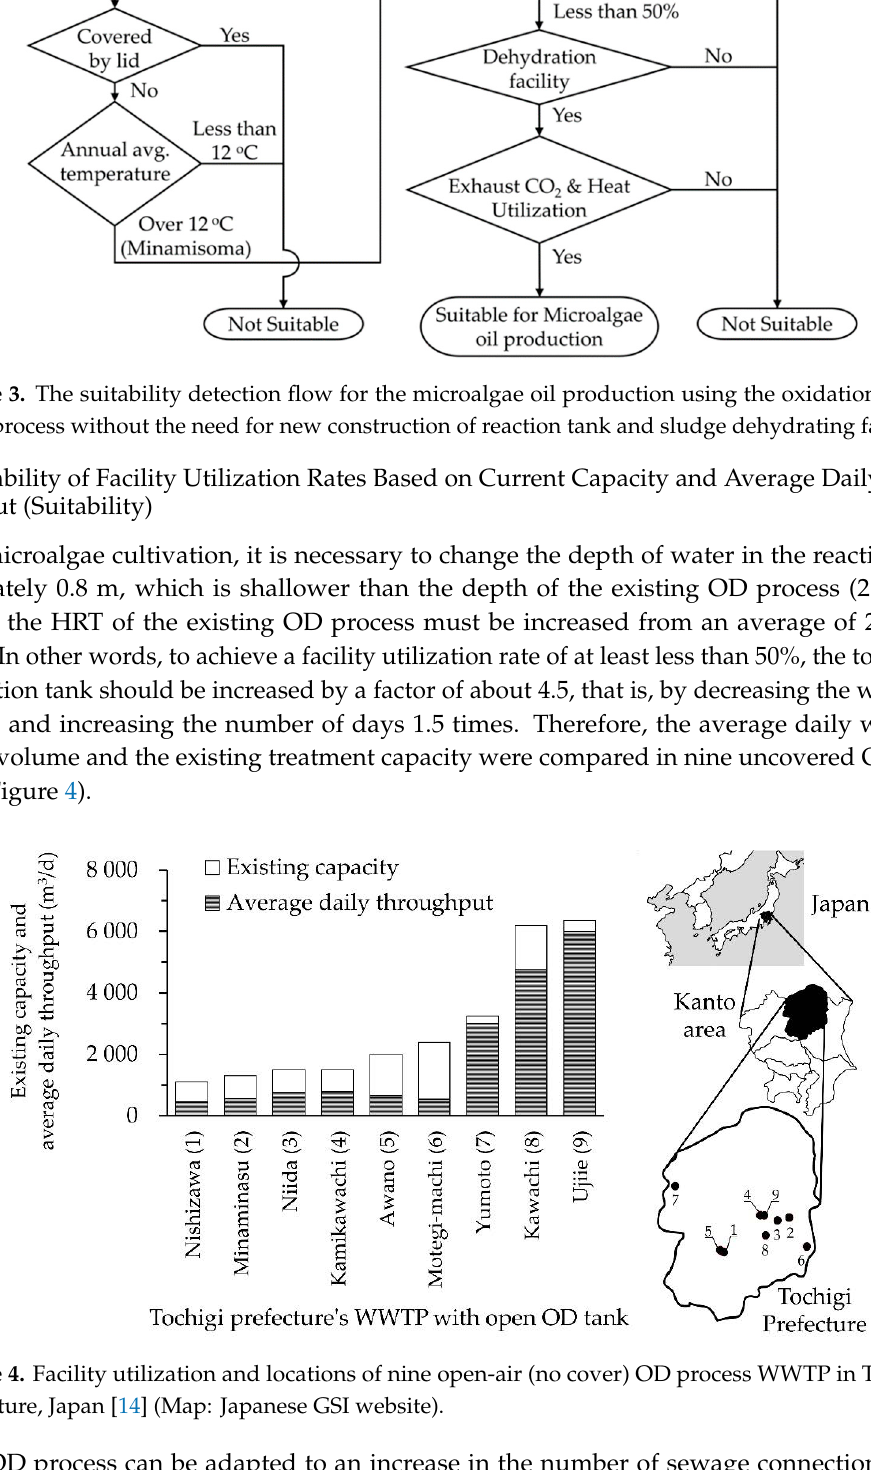
Figure 4. Facility utilization and locations of nine open-air (no cover) OD process WWTP in Tochigi Prefecture, Japan [14] (Map: Japanese GSI website).